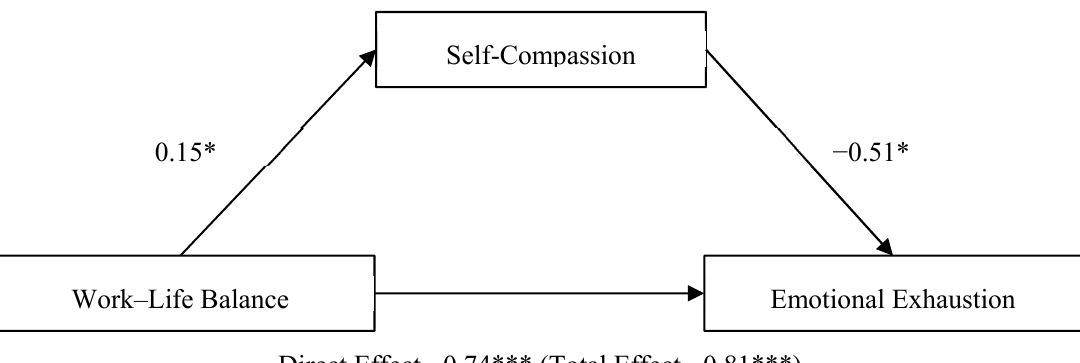
Figure 1. Parallel mediation model: work–life balance as a predictor of emotional exhaustion, mediated by self-compassion. * p < 0.05; *** p < 0.001.